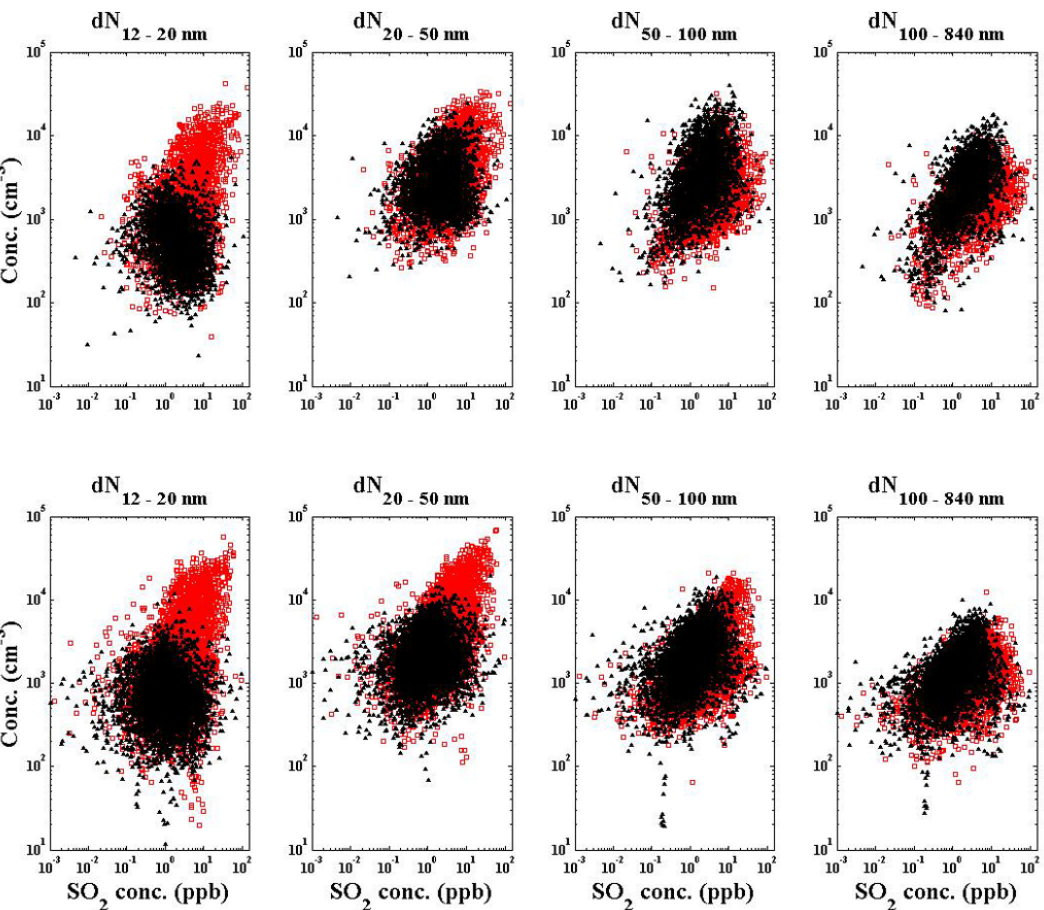
Fig. 8. Number concentrations of nucleation (d N 12 − 20nm ) , Aitken (d N 20 − 50nm and d N 50 − 100nm ) and accumulation (d N 100 − 840nm ) mode particles are presented as a function of SO 2 concentration during the dry season (upper panel) and the wet season (lower panel). Red dots indicate daytime concentrations (between 06:30–17:30) and black dots represent night-time (between 18:30–05:30) concentrations.